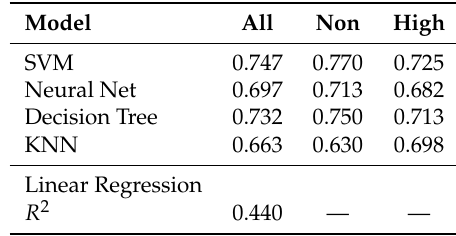
Table 1. Results for running our classification models and linear regression on the MLD dataset. Details for the training and testing procedure are provided in Section